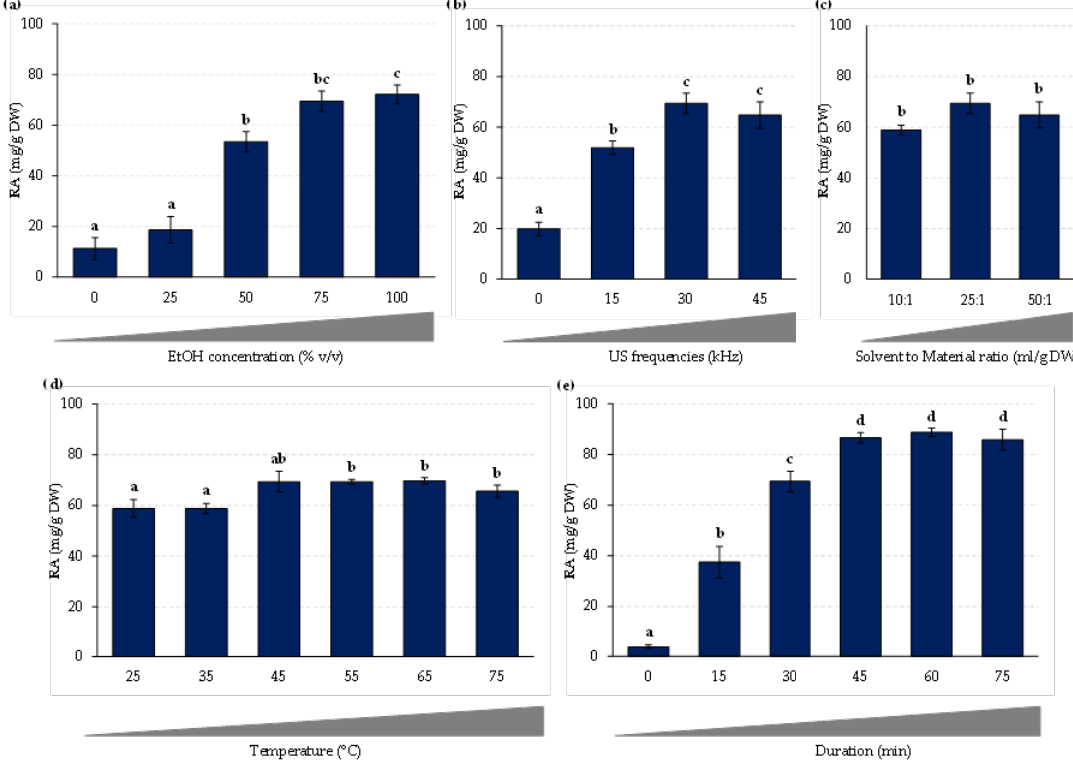
Figure 2. RA contents extracted from P. scutellarioides leaves as of function of ( a ) ethanol concentration, ( b ) ultrasound frequency, ( c ) solvent to material ratio, ( d ) extraction temperature, and ( e ) extraction duration. For a complete description of the extraction conditions, see text. Values are means ± SD of 3 independent replicates. Different letters (a–d) represent significant differences between the various extraction conditions ( p < 0.05).